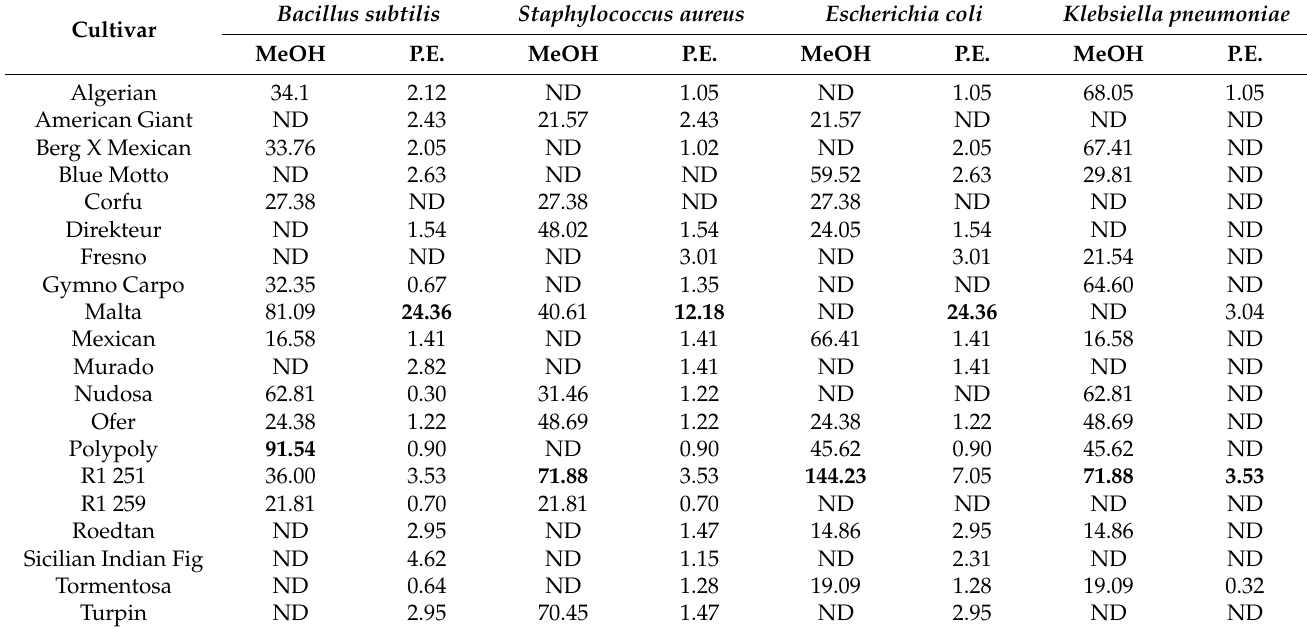
Table 5. Total antibacterial activity (minimum inhibitory dilution; mL/g) of cladode extracts from 20 selected spineless cactus pear